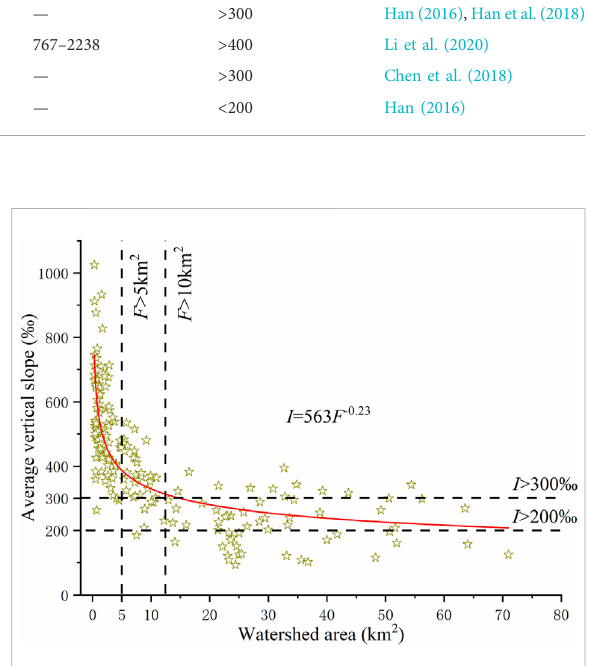
FIGURE 2 Average vertical slope versus watershed area of 176 channel- type debris fl ow gullies in the meizoseismal